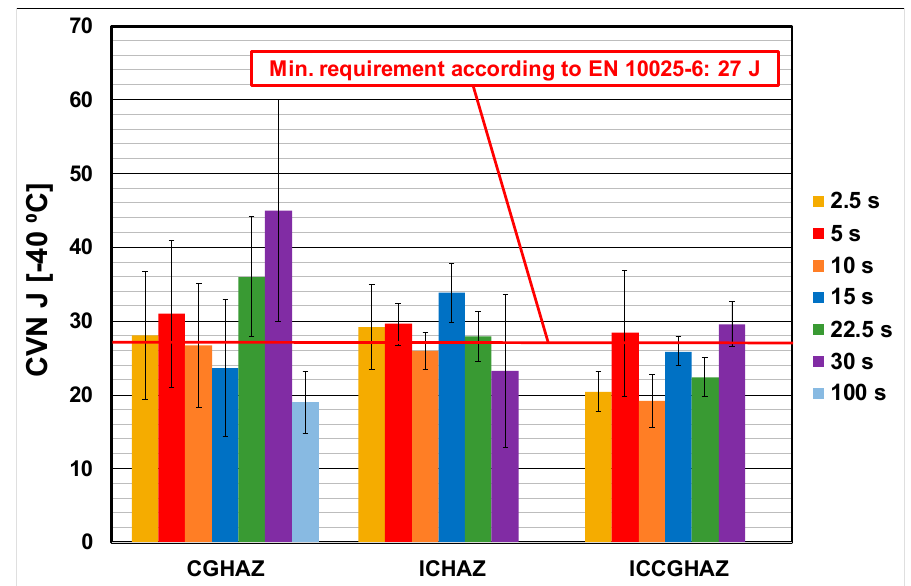
Figure 9. Charpy V-notch pendulum impact tests on HAZ subzones.